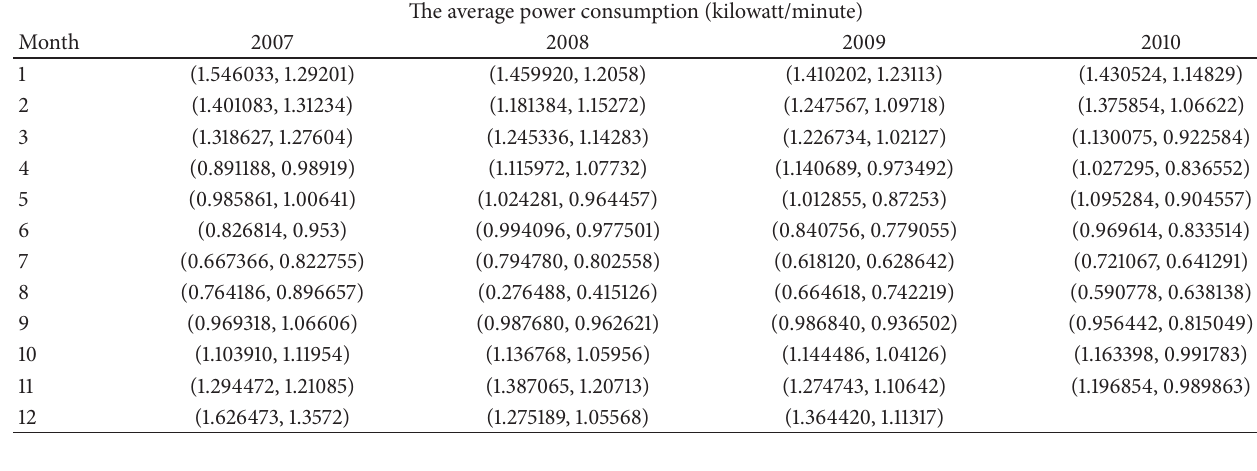
Table 2: The converted normal grey sequence of dataset 1.